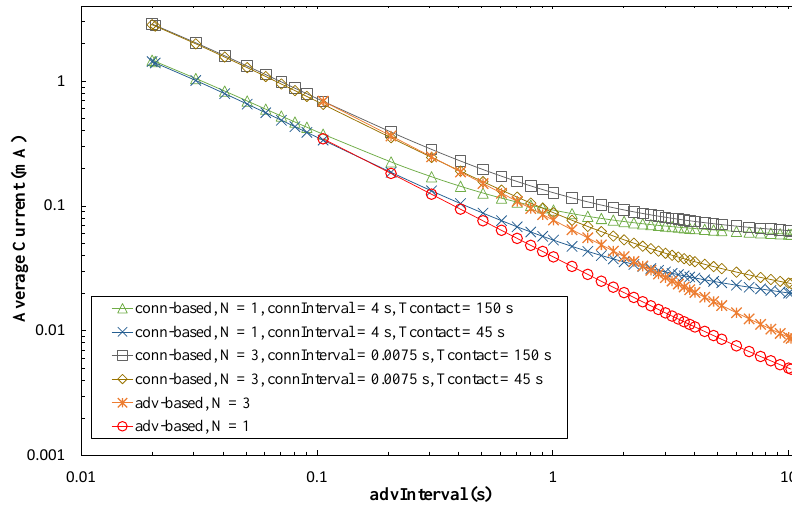
Figure 16. Average current consumption of the sensor node, for the advertisement-based and connection-based approaches, as a function of advInterval and for different N and T contact values, and for BER = 0.